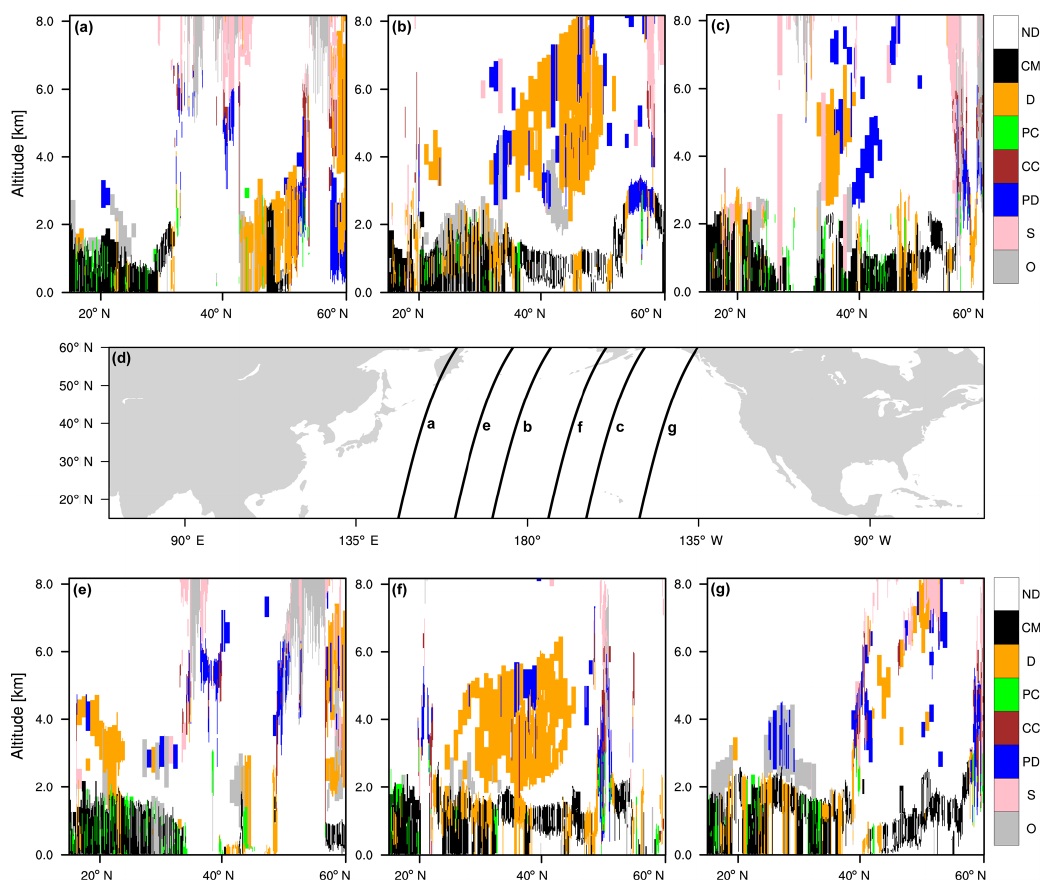
Figure 10. Vertical profiles of atmospheric features derived from CALIPSO satellite VFM data on 7 May (a, b, c) and 8 May (e, f, g) 2017. (ND: not determined, CM: clean marine, D: dust, PC: polluted continental, CC: clean continental, PD: polluted dust, S: smoke, O: other). Satellite trajectories of the vertical profiles were presented in (d)